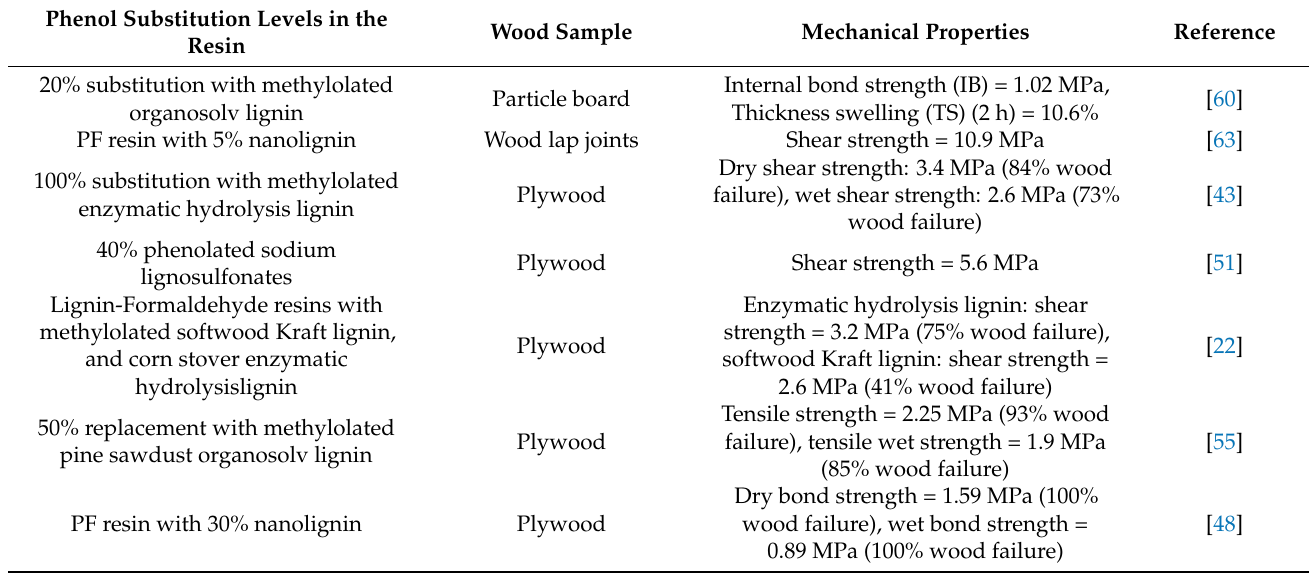
Table 1. Resin composition, sample type, and mechanical properties of selected PF resins described in